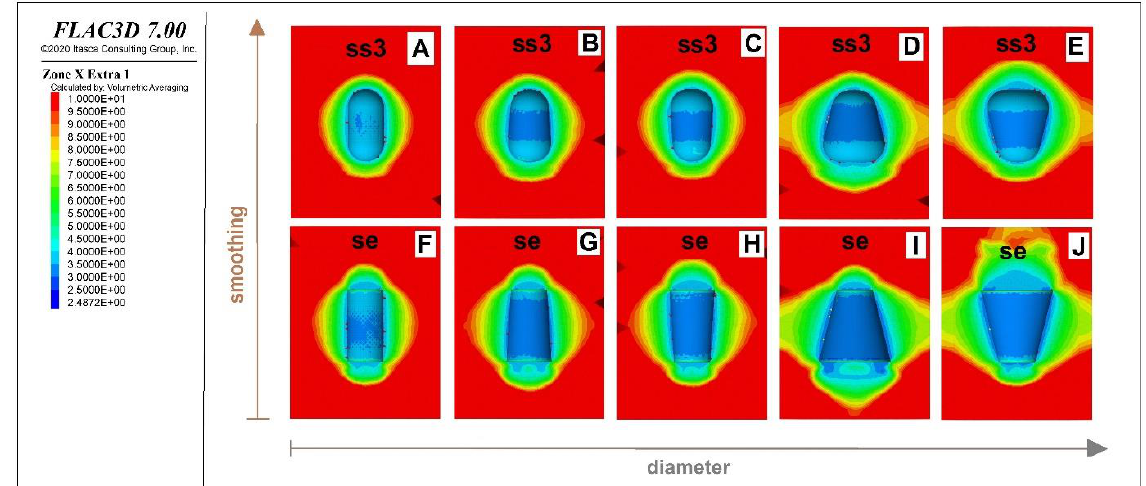
Figure 21. The low SF distribution in caverns; the first withdrawal period: ( A , F ) cylindrical shape, ( B – D ), ( G , H ) maximum initial diameter of 75 m, ( D , E , I , J ) maximum initial diameter of 120 m.